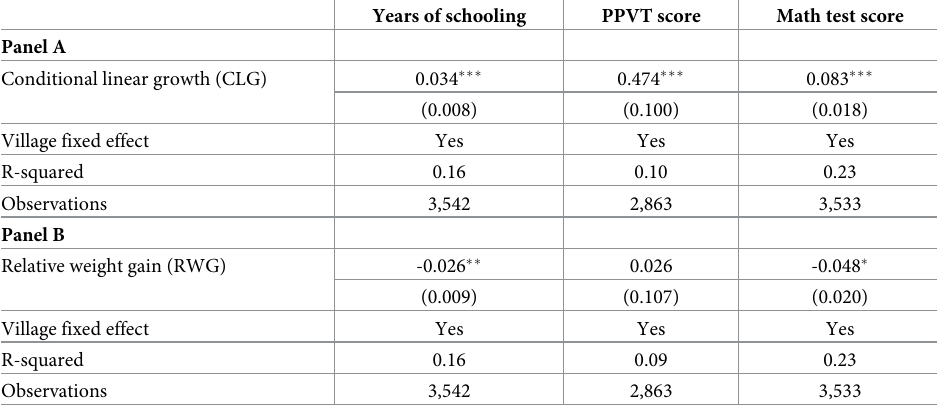
Table 3. Effect of conditional linear growth and relative weight gain on educational